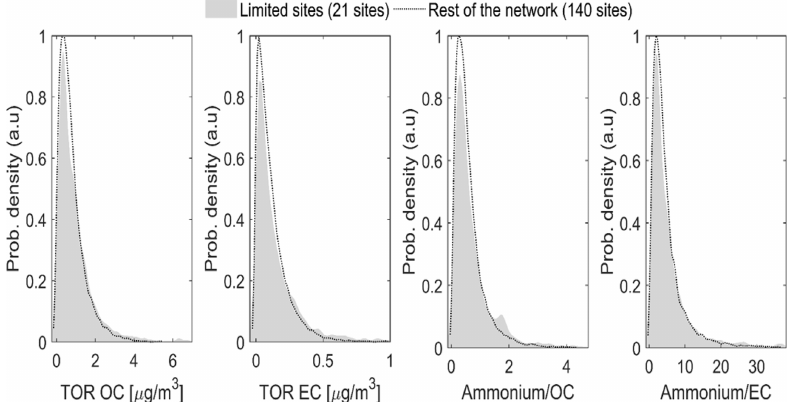
Figure 2. Comparison of probability density function for OC and EC concentrations and ammonium relative to OC and EC in 2015 between the 21 sites retained for limited calibration and the rest of the